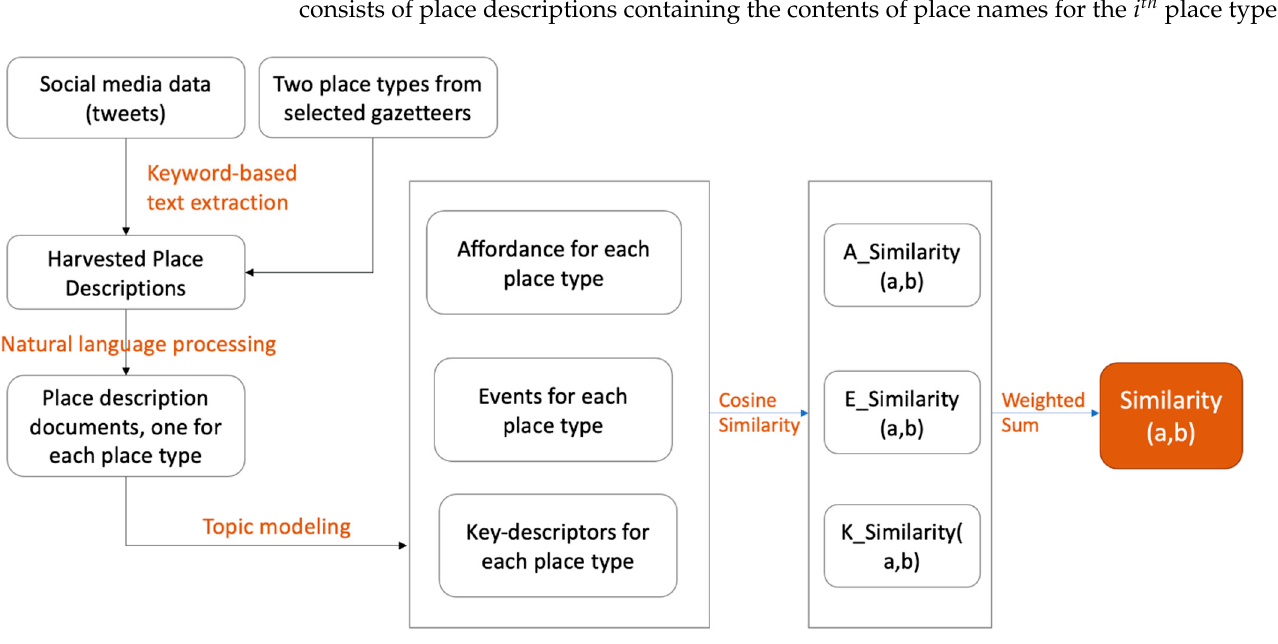
Figure 2. The overall research design for assessing place type